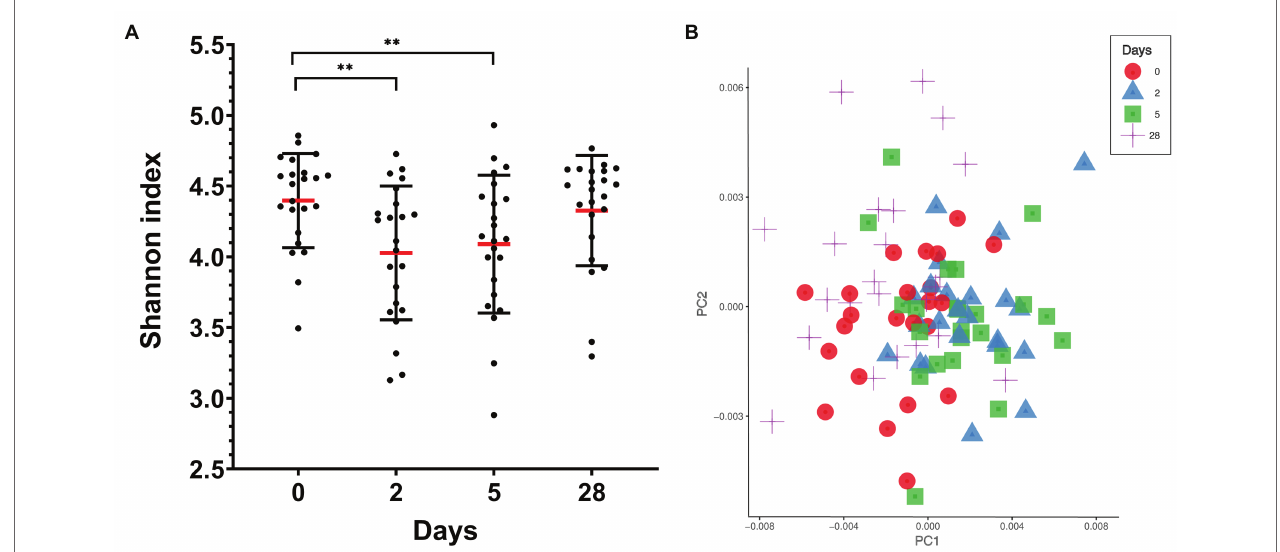
FIGURE 2 | Oral microbiota diversity in saliva from commercial saturation divers ( n = 23) before, during, and after 28 days of heliox saturation. (A) The alpha diversity within samples, i.e., species richness and evenness, is given by the Shannon index (** p < 0.001). Means (red line) and individual values are shown. Error bars are ±1 SD. (B) Principal coordinate analysis (PCoA) plot of beta-diversity for individual samples showing the first two principal components (PC1 and PC2) using Bray-Curtis distances ( p = 0.001 using permANOVA). Colored symbols indicate times of sample collection. In both panels, day 0, before saturation; days 2 and 5, during the bottom phase; day 28, after decompression.